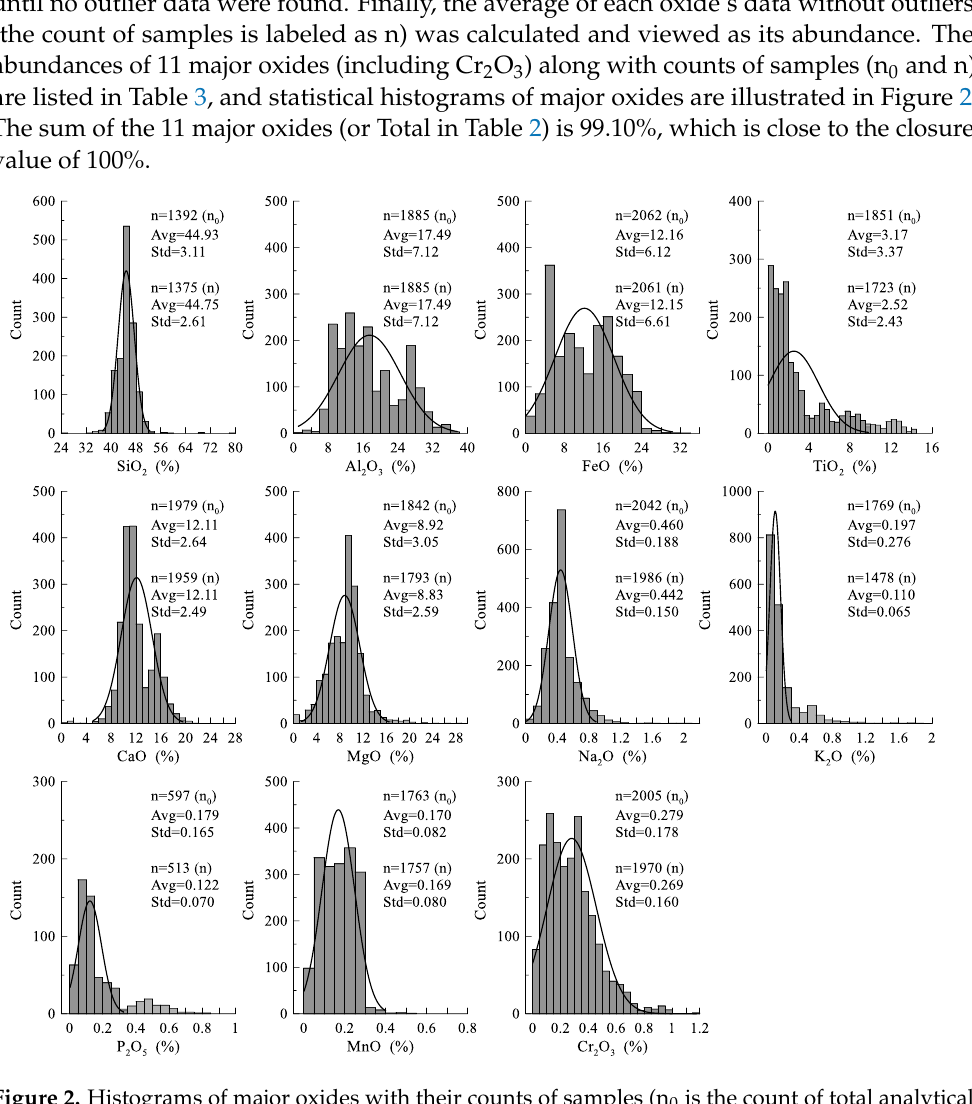
Figure 2. Histograms of major oxides with their counts of samples (n 0 is the count of total analytical data and n is the count of analytical data without outliers). The histogram of K 2 O contents is drawn without the three highest values of 5.8, 3.2, and 3.1, and the histogram of P 2 O 5 contents is without the two highest values of 1.38 and 1.1.